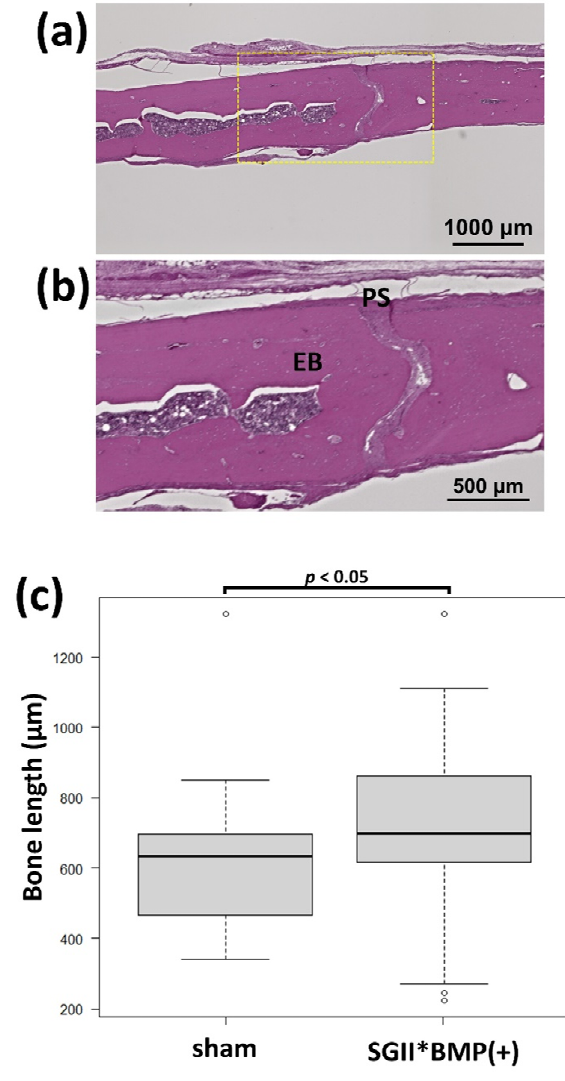
Figure 16. ( a ) The low-magnified HE image of the sham rat cranial bone, ( b ) the high-magnified HE image of the yellow rectangle area in Figure 16a, and ( c ) the tool-box graph of multiple line-scaled bone length of cranial area bone using test SG II (SG II*BMP (+) = x-tHyA + nHAp + BMP) and sham cranial bones. The statistical analysis was performed by Mann–Whitney U test.